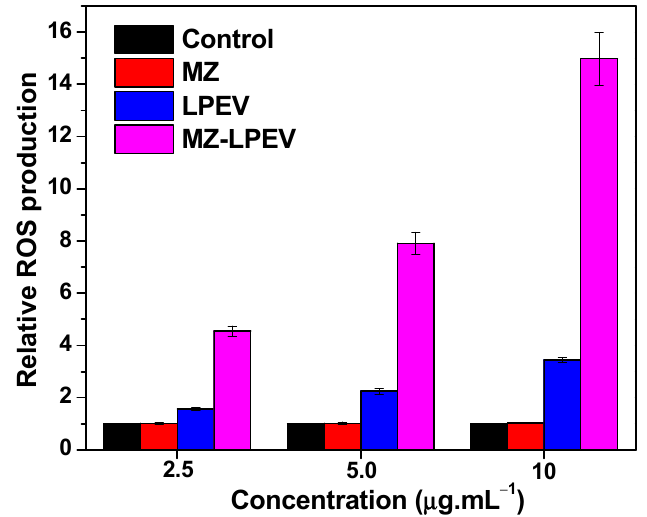
Figure 5. Relative ROS production. Fluorescence intensities at 520 nm were measured for S. aureus (ATCC 25923) cells treated with MZ, LPEV, and MZ-LPEV, respectively, and a relative ratio to the control sample is shown. Bacterial cell suspension in PBS without treatment was used as a control. MARS Data Analysis software (ver. 3.02 R2; BMG Labtech GmbH, Ortenber, Germany) was used for data processing and averaged values of relative ROS production from triplicate experiments are shown ( p < 0.05).